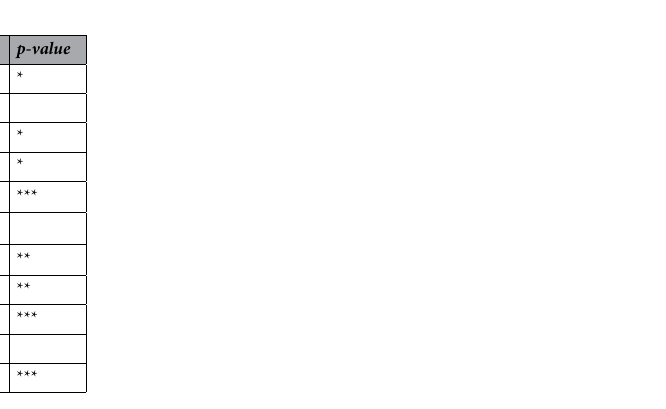
Table 3. Estimation and significance of predictors in the quadratic model. X 1 , X 2 , X 3 represented VS loading rate of swine manure, waste kitchen oil/manure ratio and temperature, respectively. Significance: ***p < 0.001, **p < 0.01, *p <